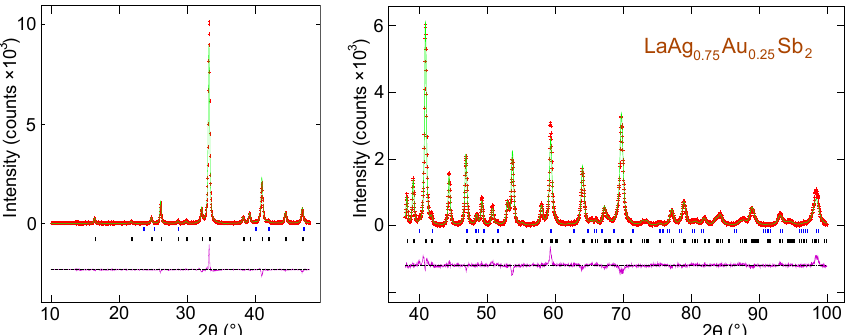
Figure 1. Cu-K α X-ray diffraction patterns for the T2 growth of LaAg 0.75 Au 0.25 Sb 2 showing the two overlapping data blocks that were co-fitted using the GSAS/EXPGUI packages [28,29]. The red points are the data and the green lines show the fits with the residuals shown below each fitted pattern. The Bragg markers show the positions of the reflections from (top) Sb, and (bottom) LaAg 1 − x Au x Sb 2 . Analysis of the X-ray diffraction as well as EDS results show (Figure 2) that the measured Ag/Au ratio deviates from the nominal with the experimental points for x meas being slightly below the x meas = x nom line with x meas / x nom = 0.88 ± 0.02 and 0.90 ± 0.03 for X-ray diffraction and EDS results, respectively. In the rest of the text we will use x -values determined from the X-ray diffraction.